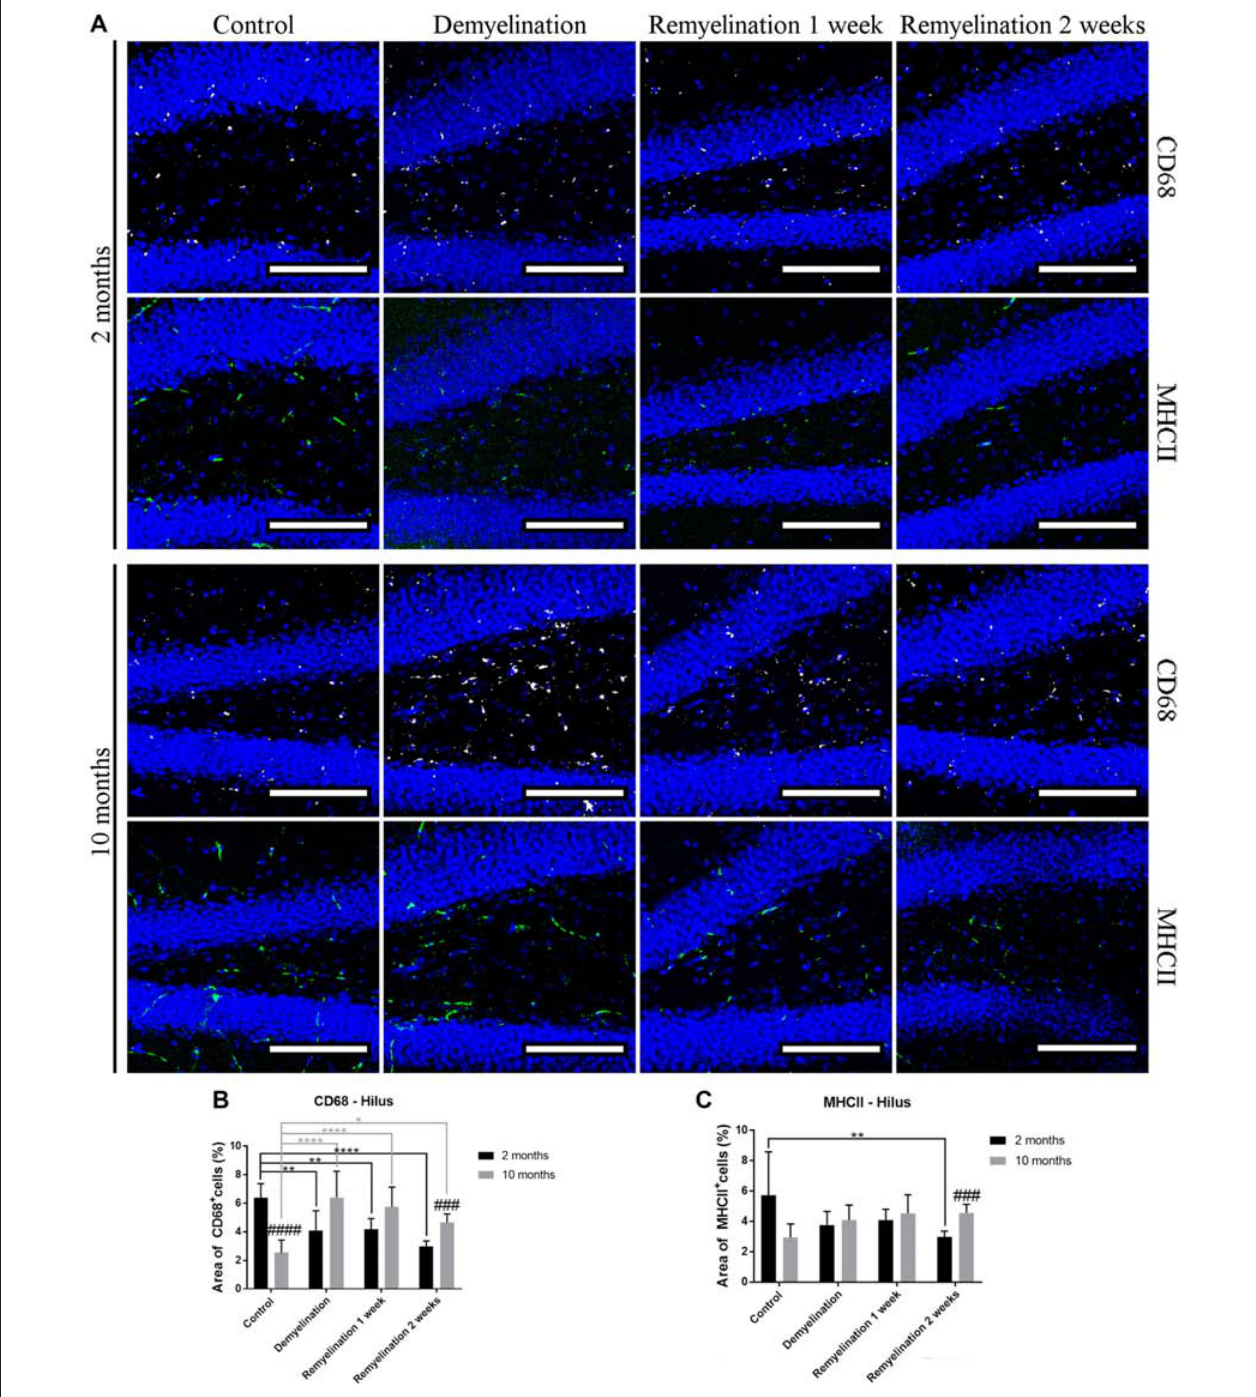
FIGURE 5 | Age-related heterogeneity in CD68 and major histocompatibility complex II (MHCII) in the hilus of the hippocampal DG. (A) CD68 (white) and MHCII (green) labeling. Cell nuclei are stained with DAPI (blue). (B) There was an age-related difference of CD68 staining in the control groups (higher in the younger controls). In the young groups, the percentage of CD68 staining decreased significantly during de- and remyelination, whereas the opposite was observed for the middle-aged groups. These different patterns led to a significantly higher CD68 level in the middle-aged group in comparison to the younger one after 2 weeks of remyelination. (C) MHCII expression was significantly reduced in the younger group after 2 weeks of remyelination. At the same time point, there was a significant age-related difference, with higher levels of MHCII in the middle-aged group. Values are shown as means + SD ( n = 6 per group). Statistical significance was evaluated using a two-way ANOVA and a Tukey’s post hoc test. The p -values are indicated in the graphs: treatment effects within the same age group: ∗ p < 0.05, ∗∗ p < 0.01 and ∗∗∗∗ p < 0.0001, age-related differences: ### p < 0.001 and #### p < 0.0001. Bars: (A) 100 µ m.